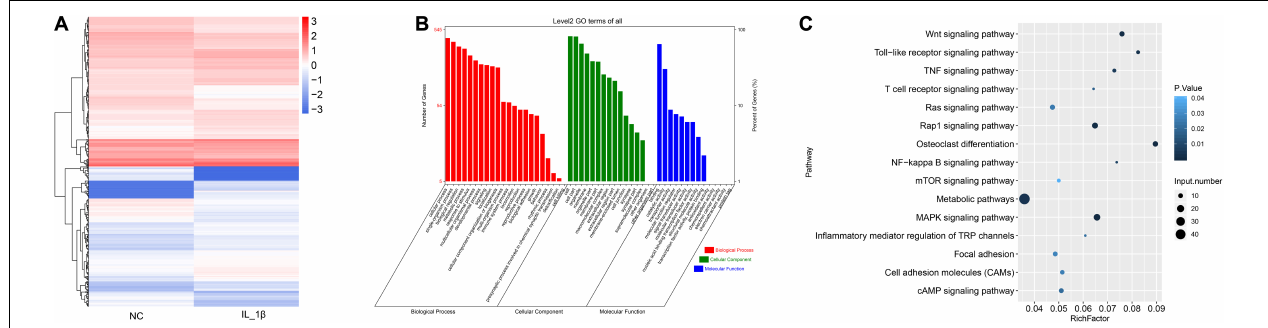
FIGURE 3 | The profile of differentially expressed mRNAs in rat chondrocytes stimulated with IL-1 β . (A) Hierarchical clustering of differentially expressed mRNAs between IL-1 β -induced rat chondrocytes and normal control chondrocytes. The chondrocyte mRNAs between two groups exhibiting a P -value < 0.05 and a Log 2 ratio ≥ 0.59 were considered as differentially expressed genes. (B) Functional categorization of differentially expressed mRNAs. Genes were categorized separately based on GO biological processes, cellular components, and molecular functions. (C) KEGG analysis results of enrichment of differentially expressed mRNAs. NC, normal control; IL-1 β , interleukin-1 β ; GO, gene ontology; KEGG, kyoto encyclopedia of genes and